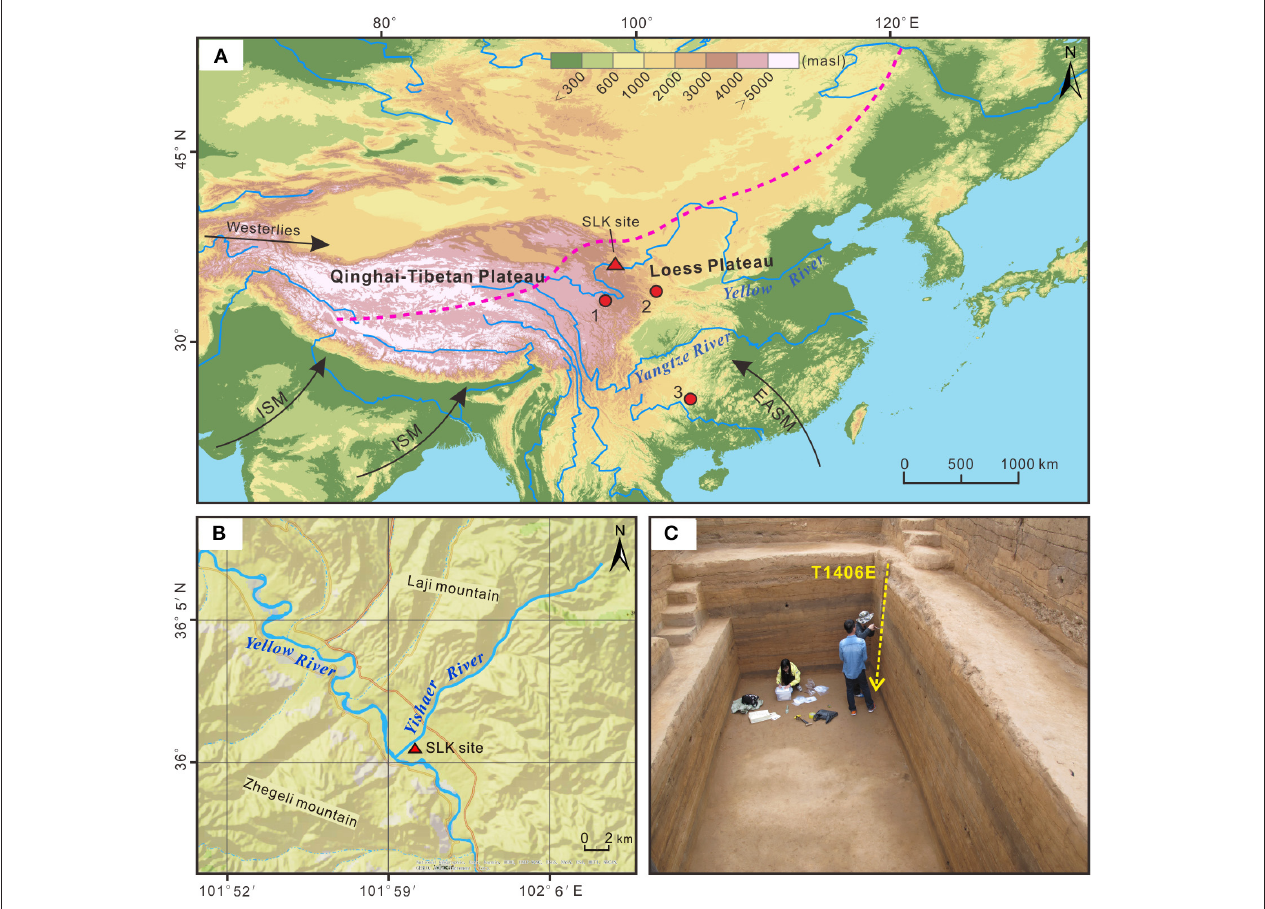
FIGURE 1 | Overview of the study area. (A) Location of Shalongka (SLK, red triangle) site and nearby sites with climate records (red circles). 1. Peat section in the Zoige Basin ( Liang et al., 2020); 2. Wuya Cave stalagmite in the western Chinese Loess Plateau (Tan et al., 2020); 3. Dongge Cave stalagmite, Guizhou Province, China (Dykoski et al., 2005). The dashed purple line indicates the modern northern limit of the Asian Summer Monsoon (Chen et al., 2008). EASM denotes East Asian summer monsoon, ISM denotes Indian Summer Monsoon. (B) Location of the SLK site in the Qunjian Basin. (C) Location of the sampling column in section T1406E (yellow dotted line) at SLK